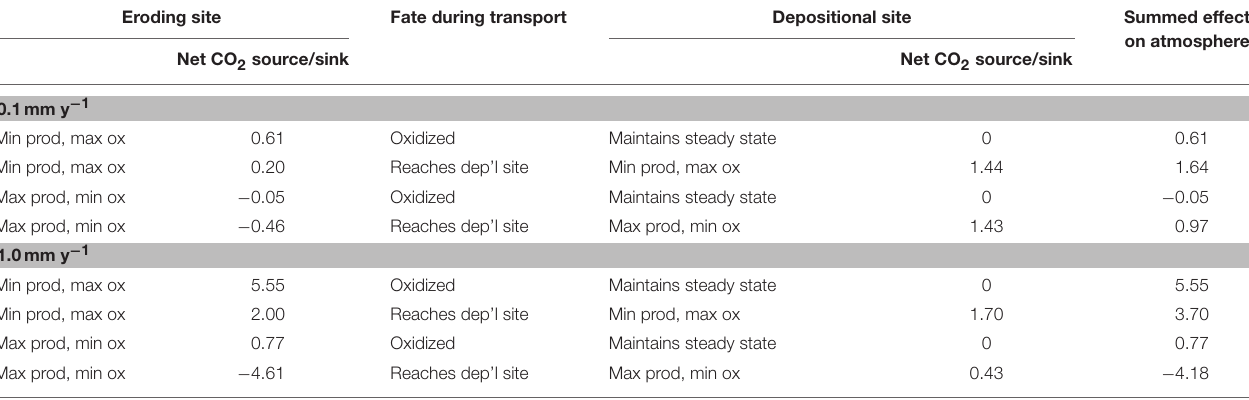
TABLE 1 | Boreal forest eroding and depositional sites’ net CO 2 source ( + ) or sink (–) strengths, and their summed effects on the atmosphere, for given soil organic C oxidation and production characteristics at both sites and two potential fates of eroded material for model runs of 100 y duration. Eroding